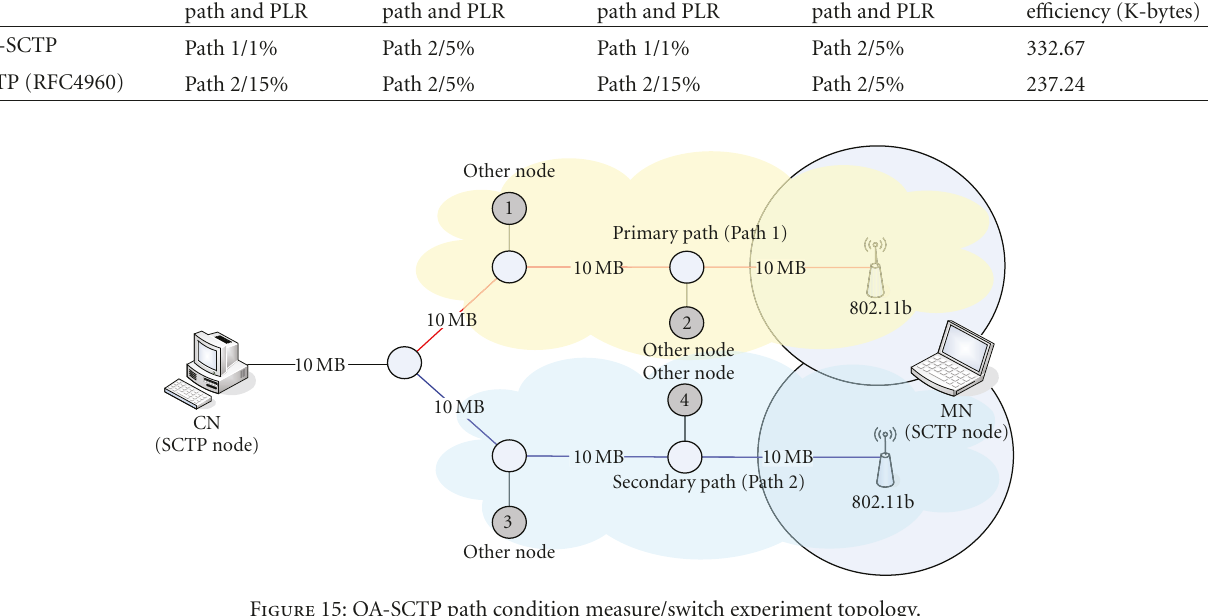
Figure 15: QA-SCTP path condition measure/switch experiment topology.